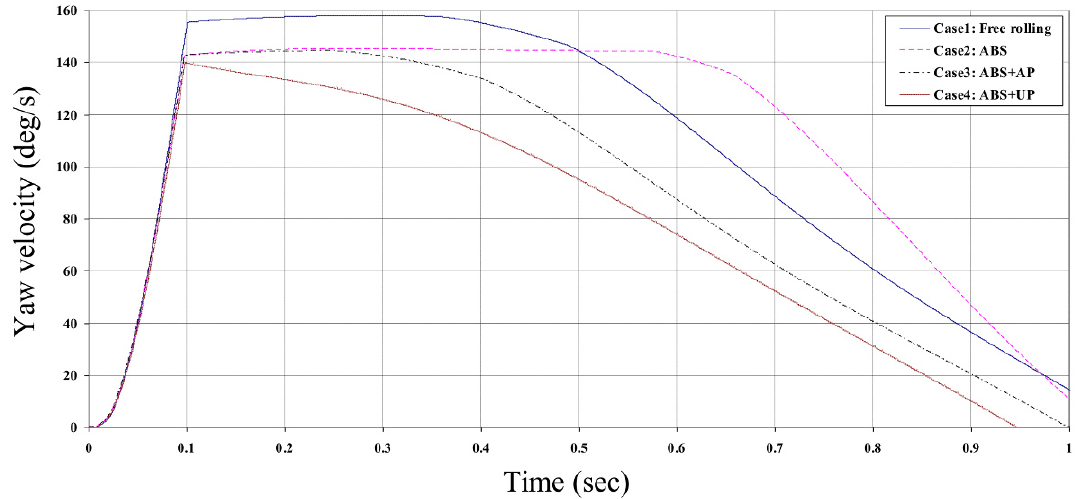
Figure 21. Yaw velocity of the vehicle body for all cases at offset collision and speed of 70 km/hr.